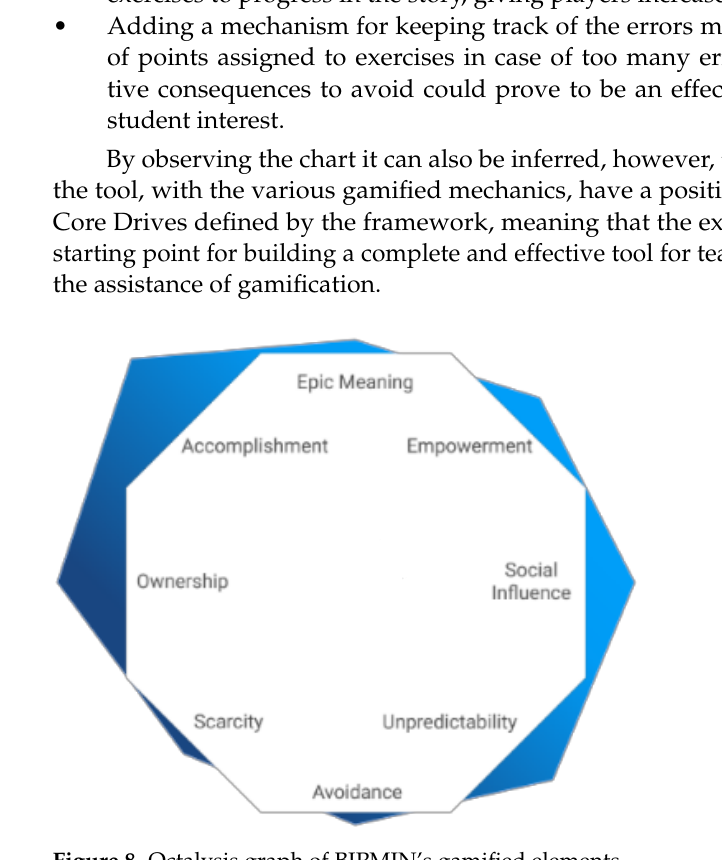
Figure 8. Octalysis graph of BIPMIN’s gamified